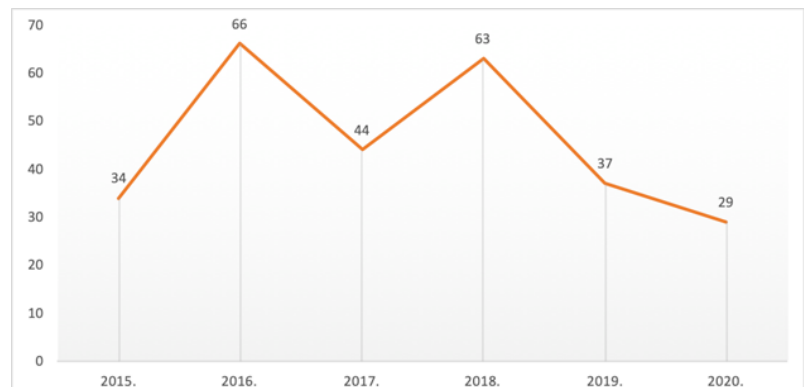
Figure 1: Criminal cases reviewed by the Supreme Court of the Republic of Latvia in accordance with Chapter 63 of the Criminal Procedure Law. [Designed by the author based on data retrieved from: Republic of Latvia Supreme Court, Archive of case-law decisions; 28 Republic of Latvia Supreme Court, Division of Case-law and Research, 2020, Nr.40-1/11-921nos 29 ] Examining the case law of the Supreme Court of the Republic of Latvia on cases relating